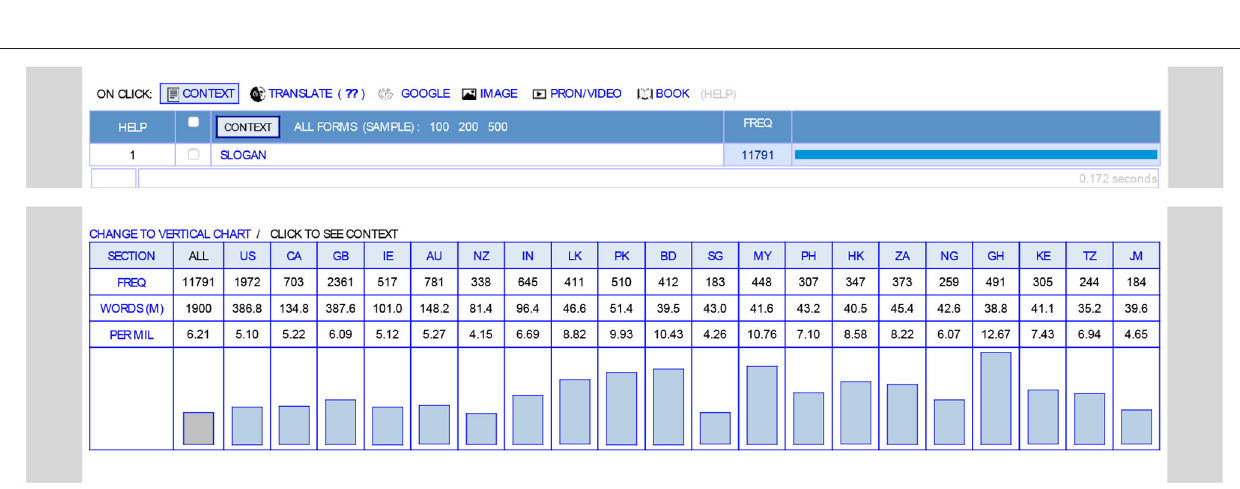
FIGURE 14 | Distribution of slogan in the GloWbE Corpus (from